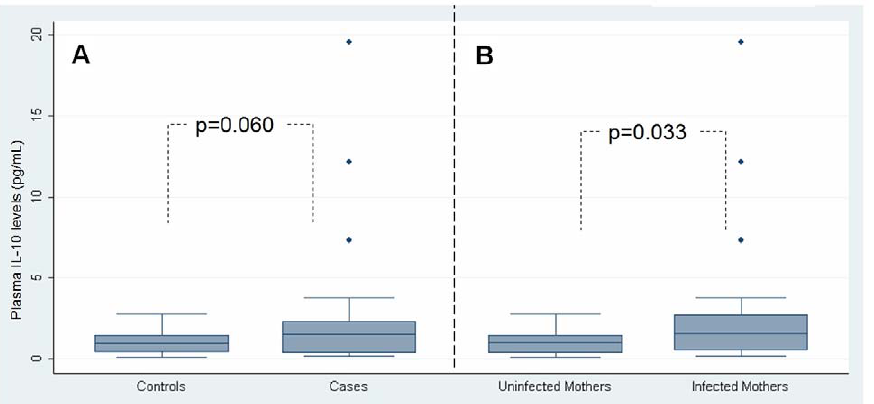
Figure 1. Plasma IL-10 levels in cord blood samples from newborns. Panel A: comparison of IL-10 levels between infected children (cases) and uninfected children (controls). Panel B: comparison IL-10 levels between children of uninfected and infected mothers. Box plots show median values (central line), inter-quartile range (box margins), 95% confidence intervals (bars), and outlying values (diamonds). Statistical comparisons were conducted using Mann-Whitney U tests.